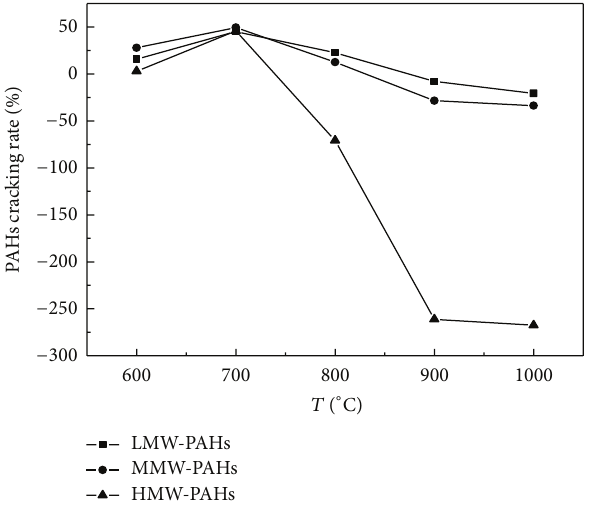
Figure 2: Relationship between the rings cracking rate distribution of PAHs and temperature under effect of CaO.